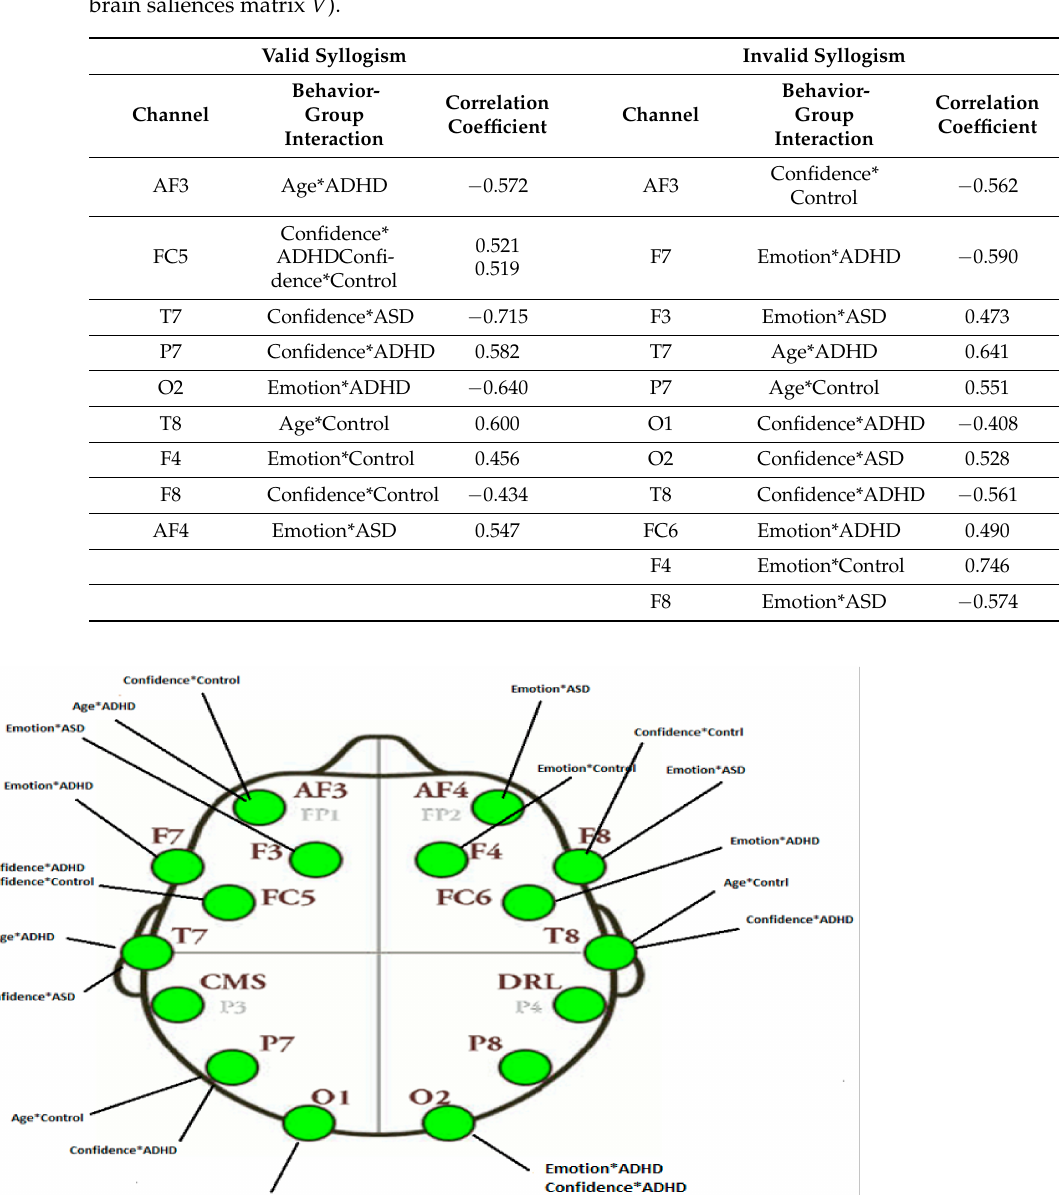
Table 10. Notable high correlations (>0.40) between pair of brain–behavior measures (extracted from brain saliences matrix V ).